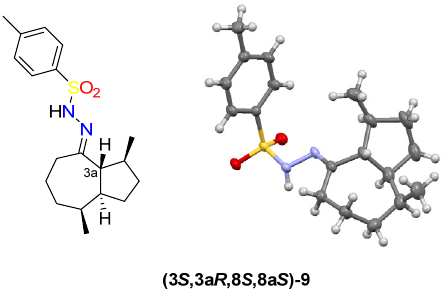
Figure 3. Stereostructure for bicyclic (3 S* ,3a R* ,8 S* ,8a S* )-9 .